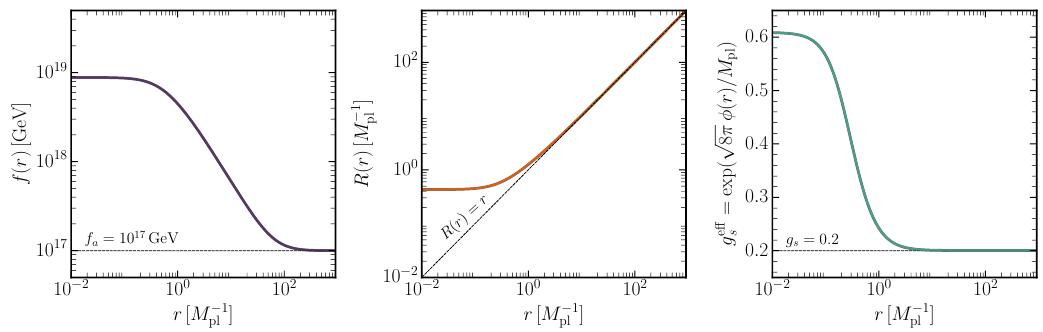
Figure 3 . The behaviour of the dynamical fields f ( r ) and φ ( r ) as well as the metric function R ( r ) for a particular numerical solution to eqs. (4.13) – (4.16). In the above, we take λ Φ = 0 . 1 , f a = 10 17 GeV and g s = 0 . 2